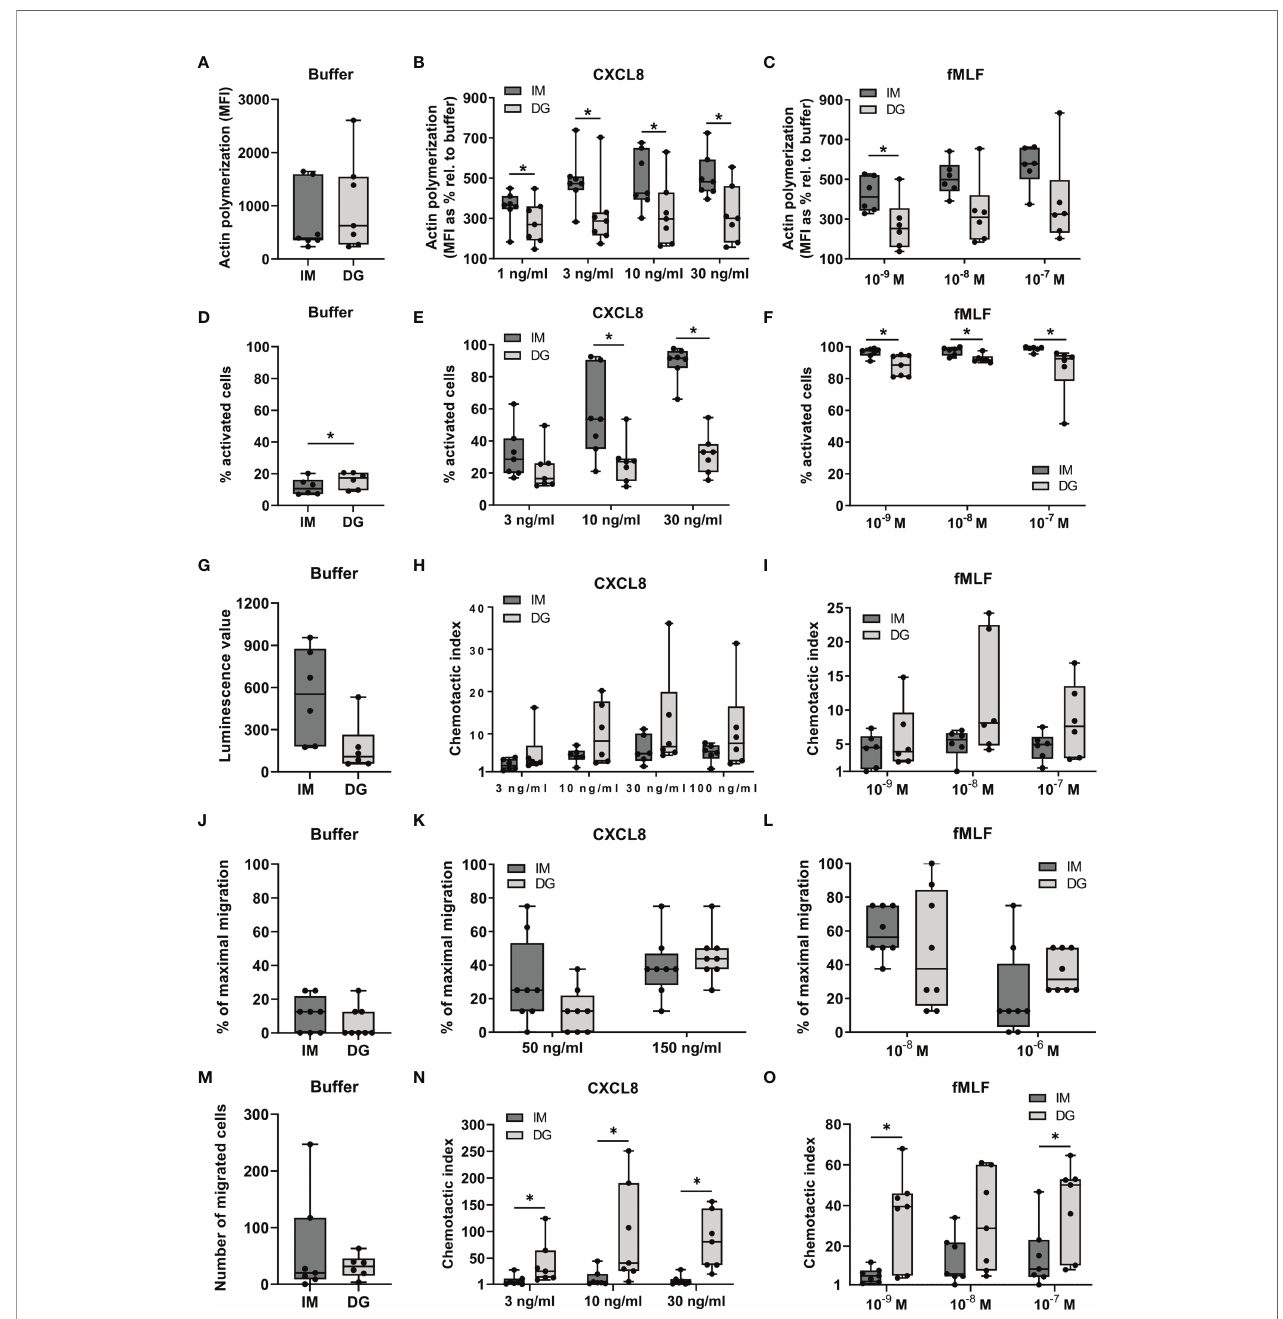
FIGURE 1 | Neutrophils puri fi ed by immunomagnetic isolation are more responsive to chemoattractants in polarization assays but not in migration assays. Peripheral blood neutrophils were isolated by immunomagnetic (IM) or density-gradient (DG) puri fi cation. (A – C) A fl ow cytometric assay was used to quantify the content of polymerized (F-) actin in the cells. Neutrophils in suspension were stimulated with CXCL8, fMLF or buffer (pre-warmed RPMI-1640 medium supplemented with 1 mg/ml HSA) for 30 seconds. Fixed and permeabilized cells were stained with Alexa Fluor 555 Phalloidin, which selectively binds to polymerized actin. (A) Results from unstimulated neutrophils (only buffer) are represented as median fl uorescence intensities (MFI). (B, C) Results from chemoattractant-stimulated neutrophils are represented as the MFIs relative to buffer control (in %). (D – F) Shape change assays were used to assess the morphological changes occurring in neutrophils in response to chemoattractants. Neutrophils in suspension were (D) left untreated or stimulated with (E) CXCL8 or (F) fMLF for a period of 3 minutes. Results are represented as the % activated neutrophils. (G – O) The (G, J, M) spontaneous and (H – I, K – L, N – O) chemoattractant-induced migratory response of neutrophils was evaluated in three different in vitro chemotaxis assays, namely: (G – I) the Multiscreen chemotaxis assay, (J – L) the under-agarose assay and (M – O) the 48-well Boyden chamber chemotaxis assay. Results are represented as (G) the luminescence value, (J – L) % of maximal migration, (M) number of migrated cells or (H, I, N, O) chemotactic indices (CI). Data are shown as box-and-whisker plots (box: median with interquartile range, whiskers: full data distribution), with each dot representing an individual healthy donor (n = 6-8). Results were statistically analyzed by Wilcoxon matched- pairs signed rank test (*p < 0.05 for statistical differences between neutrophils puri fi ed with immunomagnetic or density-gradient